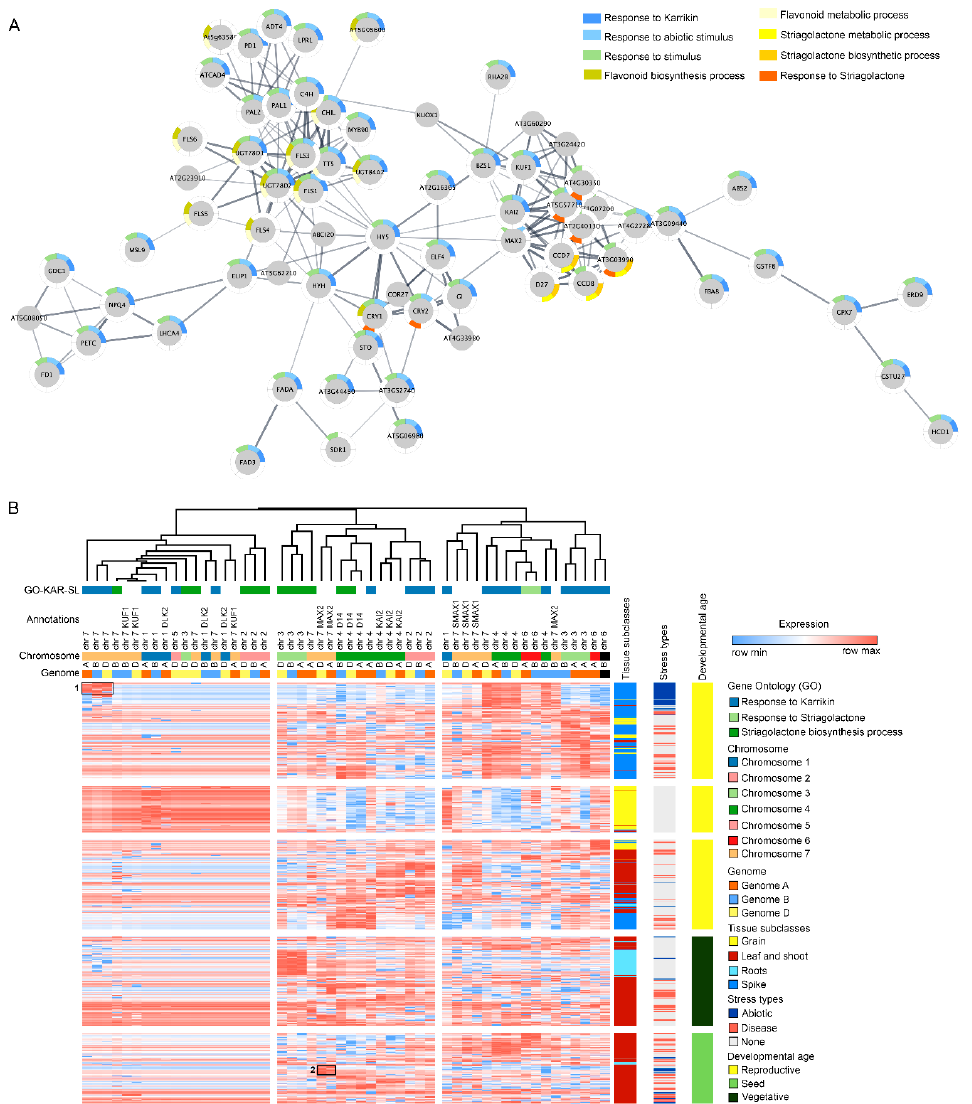
Figure 2. Genes associated with the known KAR and strigolactone (SL) cross talk can be identified in wheat and related crop species. ( A ) The dynamics of selected GO categories for KAR and SL proteins were captured in a protein–protein interaction map using proteins related to KAR and SL-associated GO terms in A. thaliana . The network built using the sequences tagged with the KAR and SL gene- associated GO terms provides evidence for the direct relationship between the two hormone signalling pathways. Node colouring in the graph depicts the significantly enriched GO terms for KAR and SL. ( B ) Gene expression patterns of homologous genes associated with KAR and SL-metabolism or signalling GO terms in wheat were analysed using transcriptome data acquired at different plant development stages and abiotic and biotic stress conditions. Dendrograms show the clustering of GO terms associated with KAR and SL, gene annotations, chromosomal locations and the corresponding common bread wheat (hexaploid) genomes A, B and D. The heat map depicts the relative transcript level of KAR- and SL-related gene expression across wheat tissues, stress subtypes and developmental stages. High expression levels in abiotic stress conditions were primarily enriched in chromosome group 7 (marked as 1); MAX2-dependent abiotic stress tolerance and KAR signalling pathways (marked as 2).